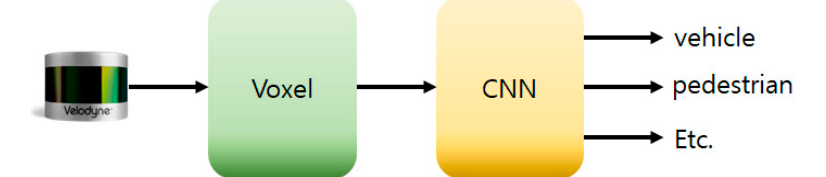
Figure 1. Network structure based on voxel.